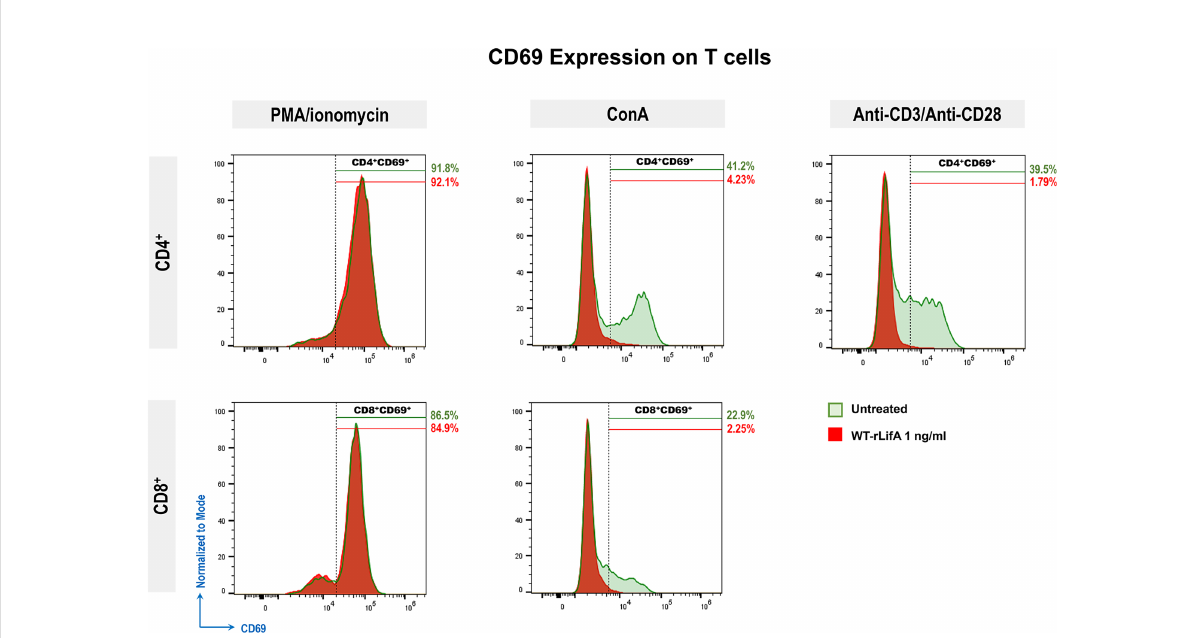
FIGURE 6 Representative histograms show CD69 expression (normalized to mode) of PMA/ionomycin, ConA, or anti-CD3/anti-CD28-stimulated CD4 + and CD8 + T cells comparing between untreated cell versus WT-rLifA (1 ng/ml) treatment. For each histogram, % is the percentage of CD69 expression on PMA/ionomycin, ConA, or anti-CD3/anti-CD28-stimulated CD4 + or CD8 + T cells upon WT-rLifA treatment (shaded areas in red) or left untreated (shaded areas in green). Histograms represent data from a technical replicate of one donor.